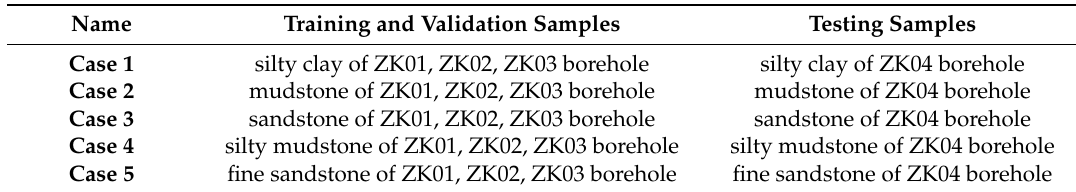
Table 1. Artificial neural network (ANN) models under different cases.